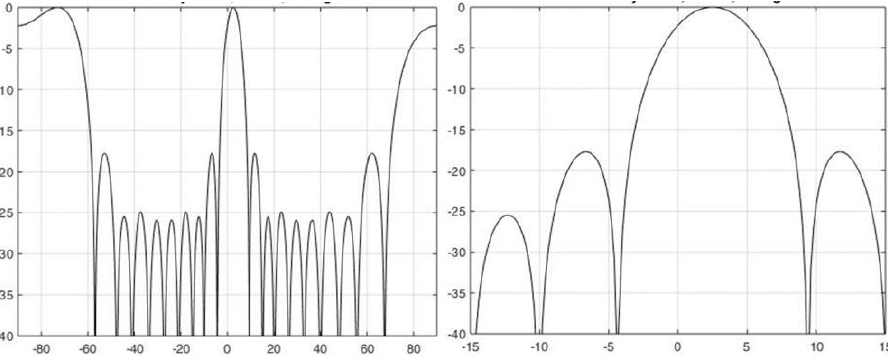
Fig. 2. 76-element antenna array factor.